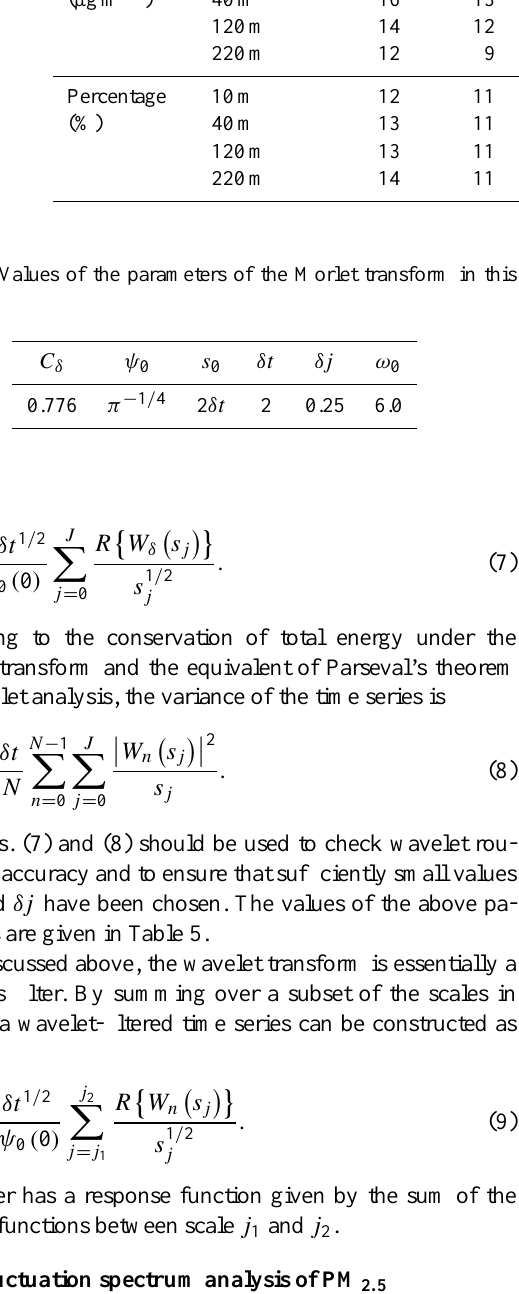
Table 4. Source contributions and percentage contributions at four different heights. Coal Crustal Cement Vehicle Secondary Secondary TOT combustion dust dust exhaust sulfate nitrate Contribution 10m